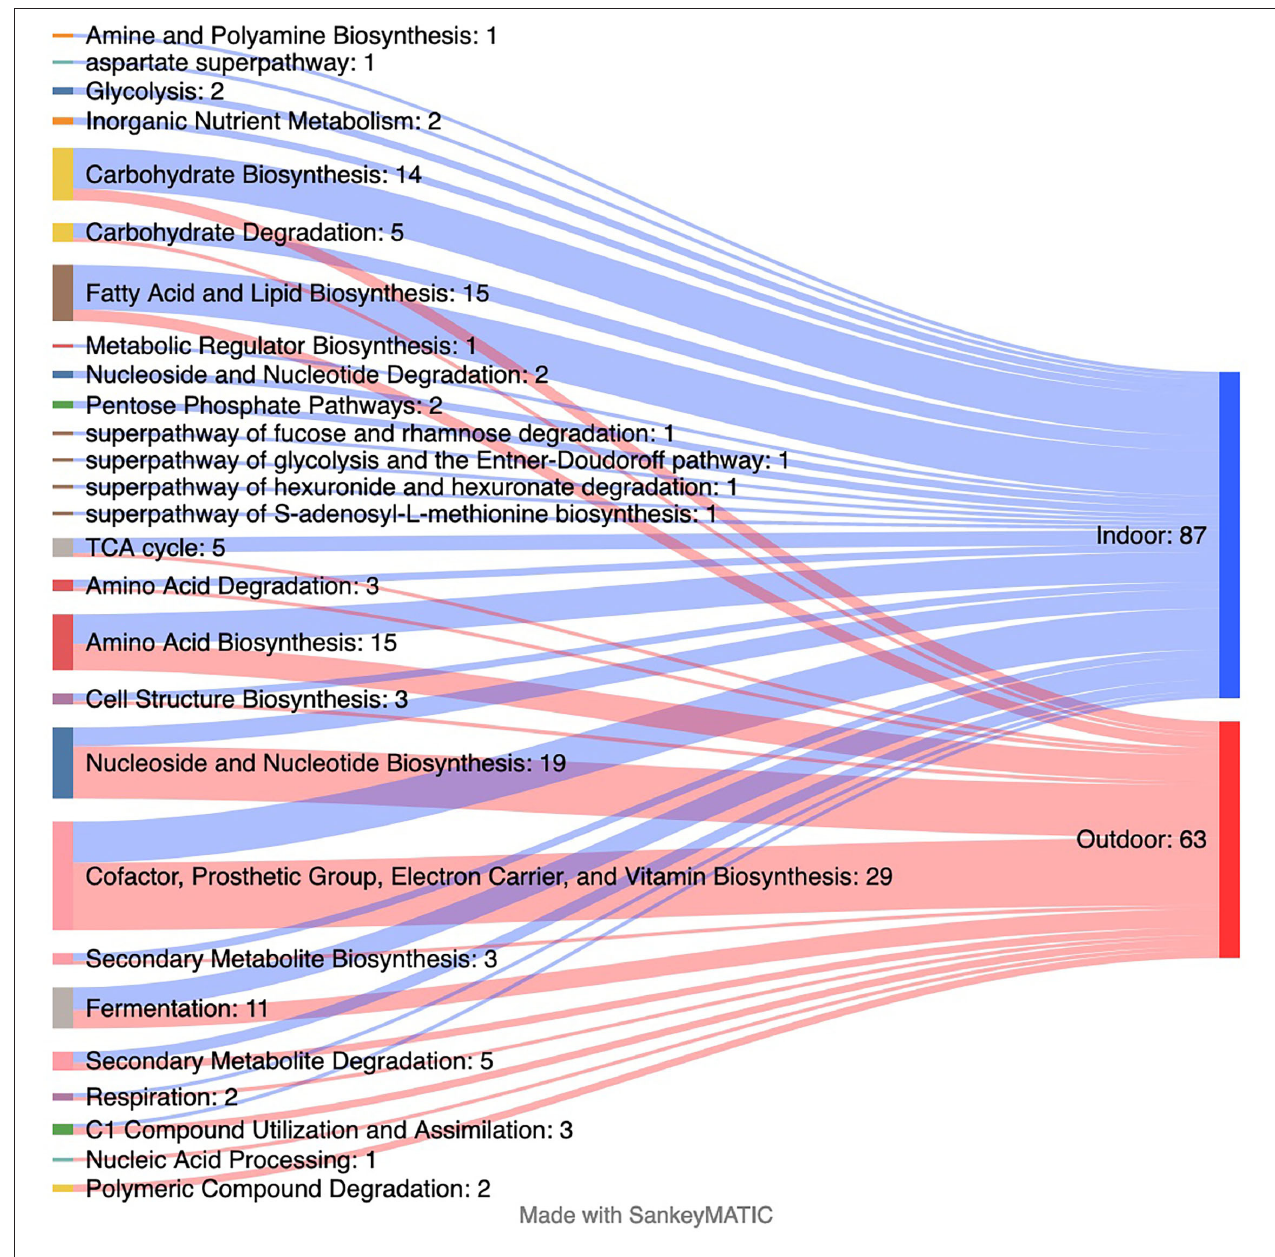
FIGURE 4 | Changes in predicted metagenomics from indoor to outdoor rearing system. The Sankey plot displaying the number of predicted MetaCyc pathways collapsed at the MetaCyc class level that is significantly enriched in each group as assessed by linear discriminant analysis (LDA) combined with effect size (LEfSe) algorithm ( p > 0.05 for both Kruskal–Wallis and pairwise Wilcoxon tests and a cutoff value of LDA score above 2.0). Refer to Supplementary Dataset 1 for the list of all significantly predicted functions at the MetaCyc pathway